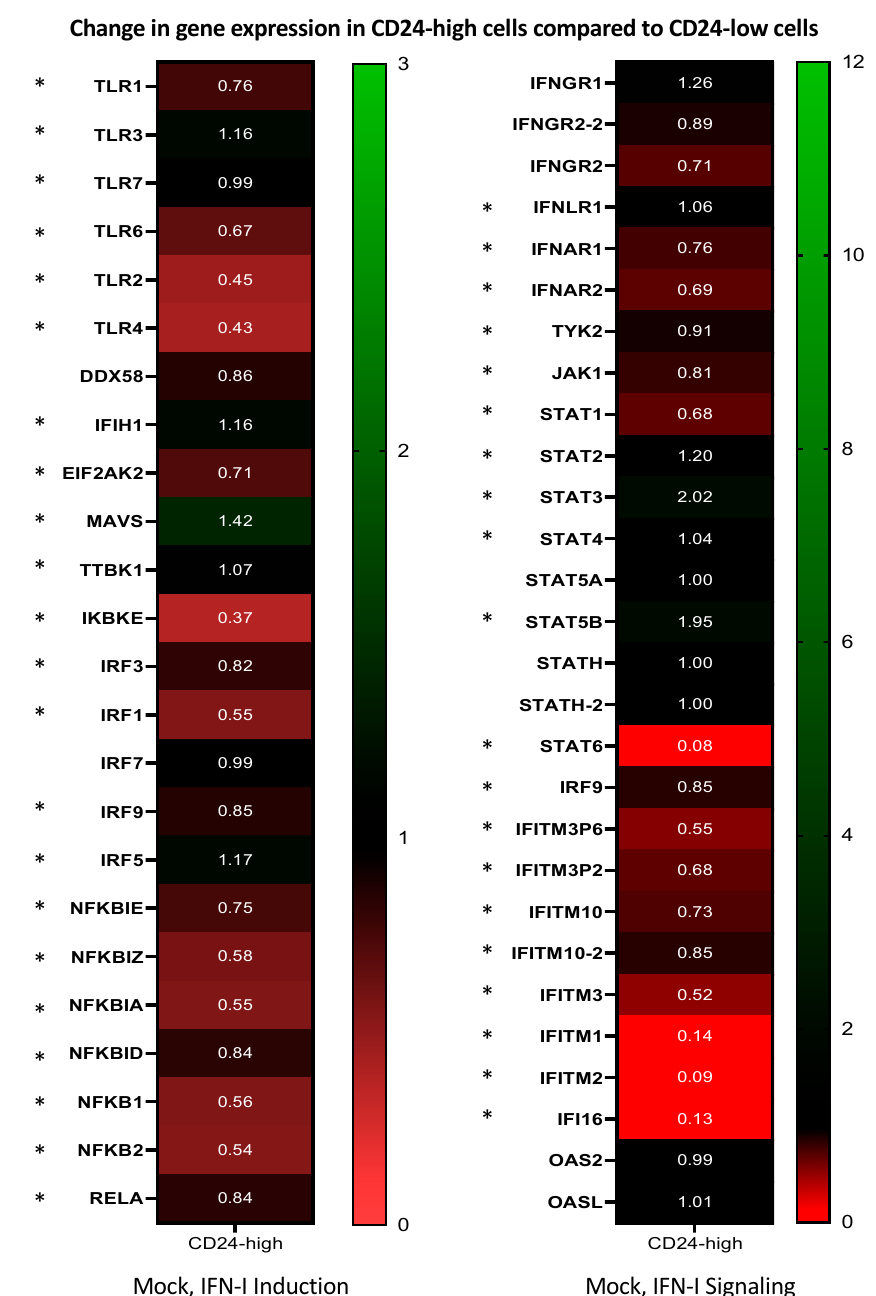
in genes observed upon ectopic CD24 expression (in CD24-high cells). As shown in Fig- ure S3, the pathways that have been significantly modulated belong to various intracellular signaling pathways, including IFN- α /ß signaling, JAK-STAT signaling, and Ras